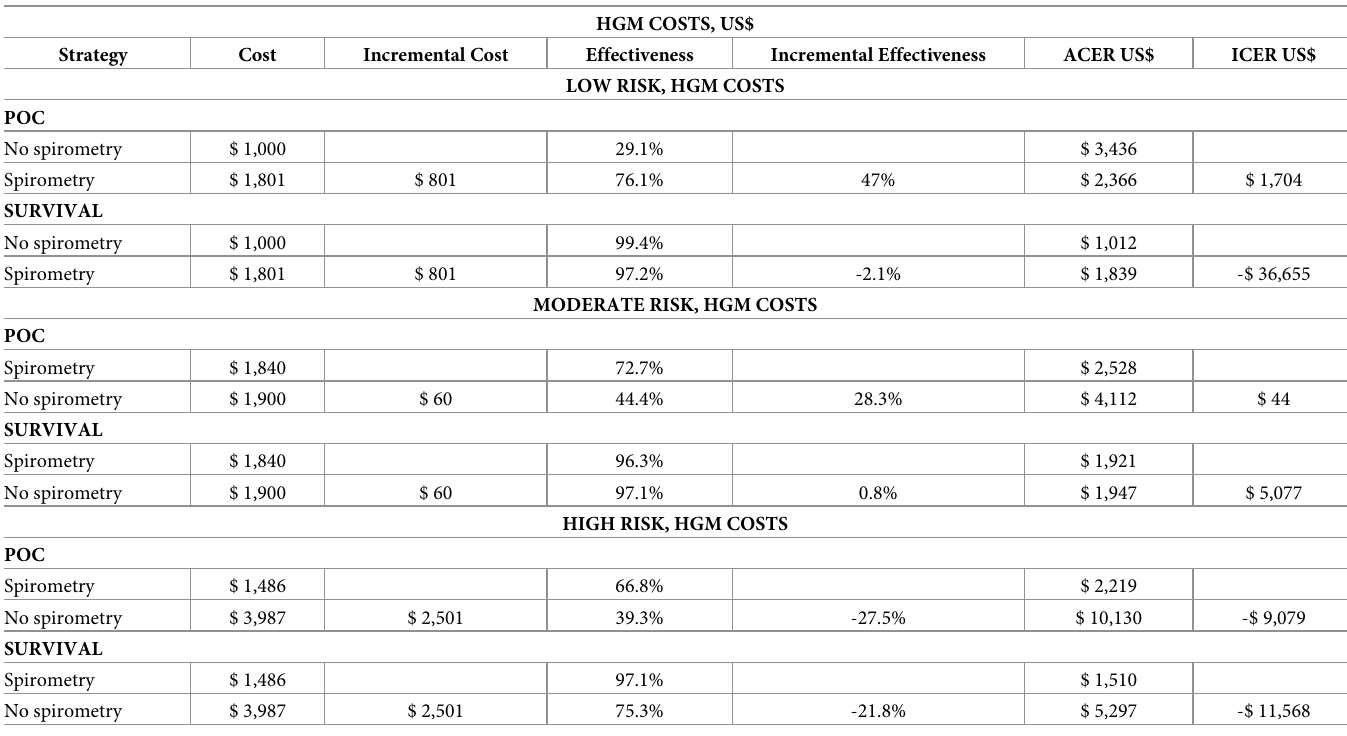
Table 2. Cost-effectiveness analysis, by ARISCAT risk level, with and without spirometry. 2019 HGM costs